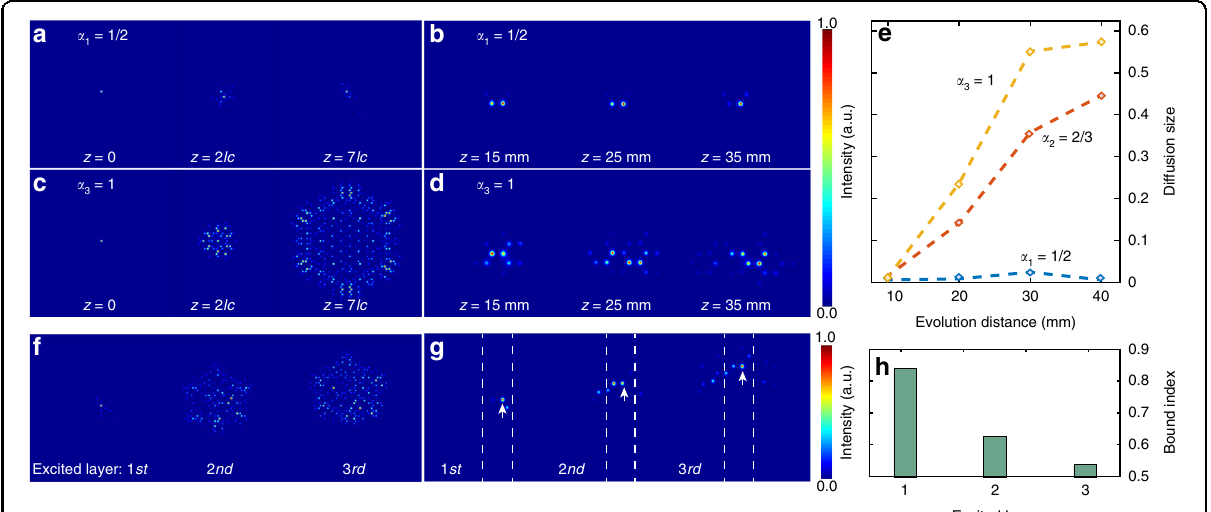
Fig. 2 The generation and transmission of bound optical vortices in deformed photonic graphene with the injection of photons into a single waveguide. a and b are respectively the theoretical calculated results and experimental results with the excitation of a single waveguide in the innermost ring layer around the cosmic string. c and d are respectively the theoretical calculated results and experimental results with the excitation of a single waveguide in the uniform graphene. e is the experimental diffusion size as the evolution distance for different density parameters of the cosmic strings. f and g are respectively the theoretical calculated results and experimental results with the excitation of a single waveguide on different ring layers after same propagational distance. The white arrows indicated the waveguide into which the input light beam was launched in g. In f the propagational distance is z = 5 l c ( l c is the coupling distance), in g the propagational distance is z = 25 mm. And the sites between the dashed lines in g were used to de fi ne the bound index that is the proportion of the photon distribution into such a zone among all sites. h is the bound index as the excitation of a single waveguide on different ring layers. The theoretical calculation was carried out in the graphene lattice whose size was 1302 waveguide sites. Whereas considering the limitation of experimental fabrication, the experimental results were determined using a graphene lattice with 150 waveguide